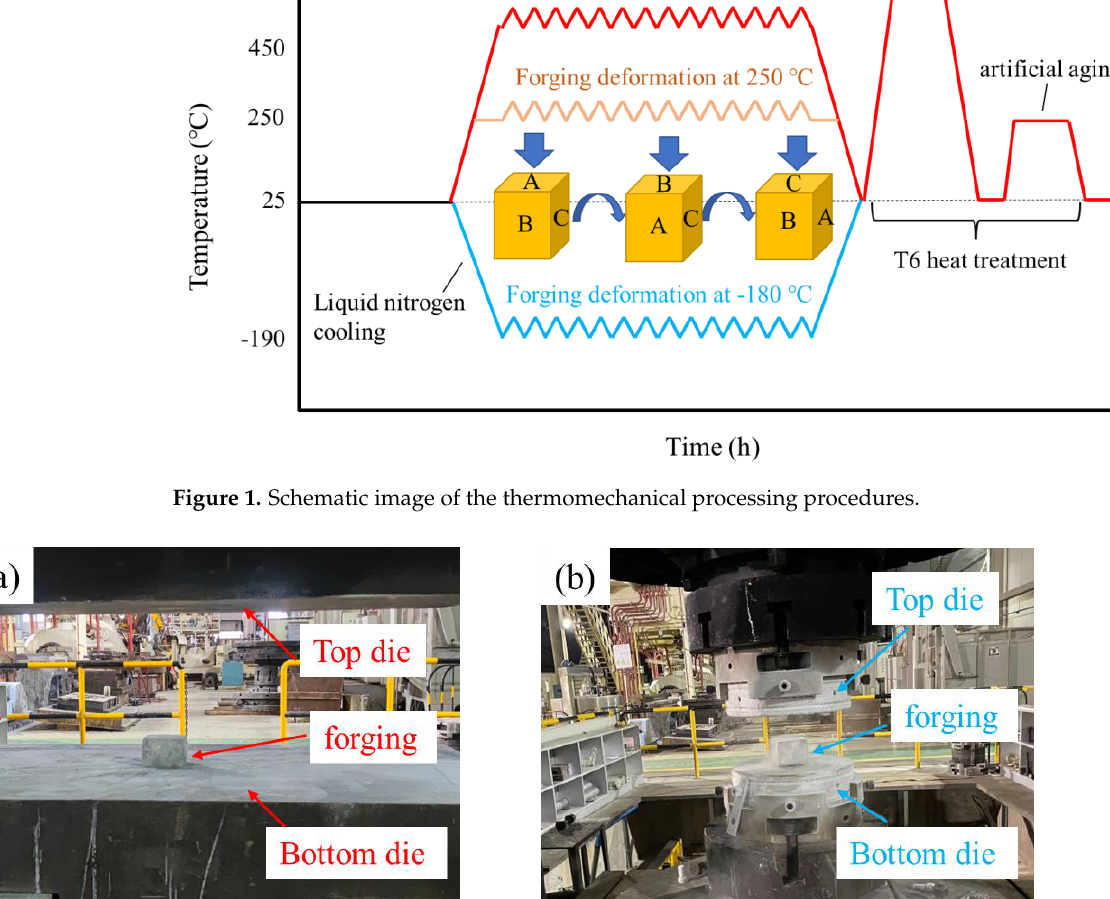
diffractometer with a Cu K α radiation source of 1.5406 Å. Three dog-bone-shaped speci-